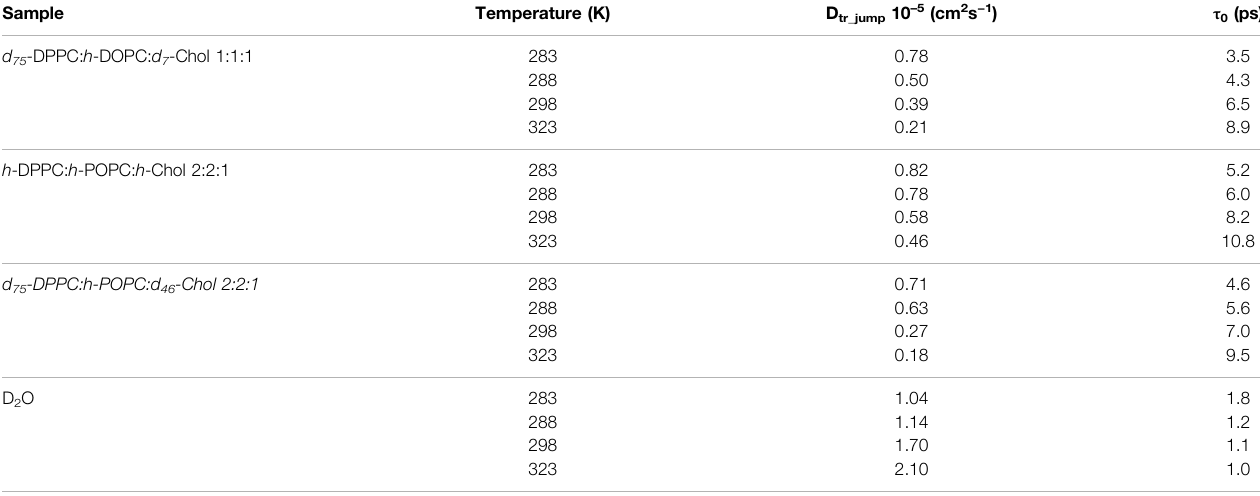
TABLE 2 | Dynamical properties extracted from the fi ts as a function of temperature (from 283 to 323 K) for h-DPPC:h-POPC:h-Chol molar ratio 2:2:1; d 75 -DPPC:h-POPC: d 46 -Chol molar ratio 2:2:1 and d 75 -DPPC:h-DOPC:d 7 -Chol molar ratio 1:1:1. In the fully protiated sample the scattering pro fi le is the result of the “ sum ” of each component ’ s dynamics (appropriately weighted). The partially deuterated samples are virtually “ invisible ” , therefore, used to only highlight dynamics from the h -component (i.e.,POPCandDOPC).Intheseregardsthecomparisonbetween2:2:1composition(e.g.fullyprotiatedandpartiallydeuterated)wouldhighlightonlythedynamicsofPOPC. The comparison between 2:2:1 vs . 1:1:1 composition (both partially deuterated) would highlight the difference in dynamics between POPC and DOPC. Sample